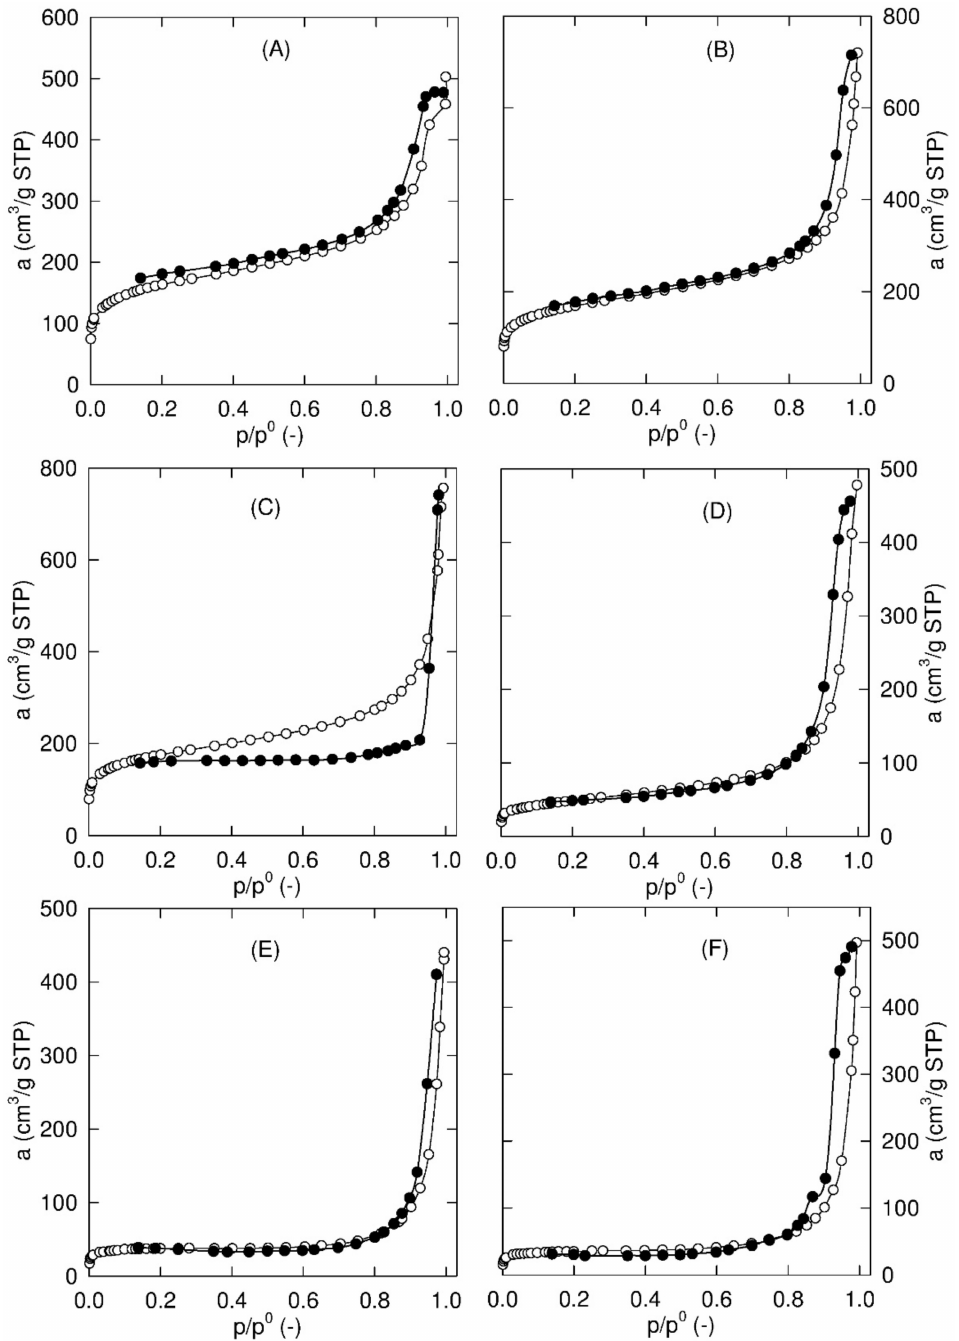
Figure 6. Adsorption ( ) and desorption ( • ) branch of the nitrogen sorption isotherm for SWCNT-200 ( A ), SWCNT-200 (cid:38) (cid:35) SiO 2 ( B ), SWCNT-200 (cid:37) SiO 2 ( C ), Mod_SWCNT-200 ( D ), Mod_SWCNT-200 (cid:38) SiO 2 ( E ), and Mod_SWCNT-200 (cid:37) SiO 2 ( F